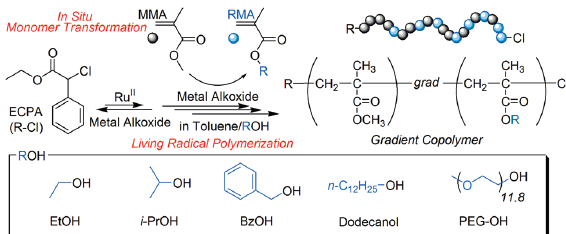
Figure 15. Synthesis of gradient copolymer by concurrent ATRP and selective transesterification. Adapted with permission from [75], Copyright© 2009 American Chemical